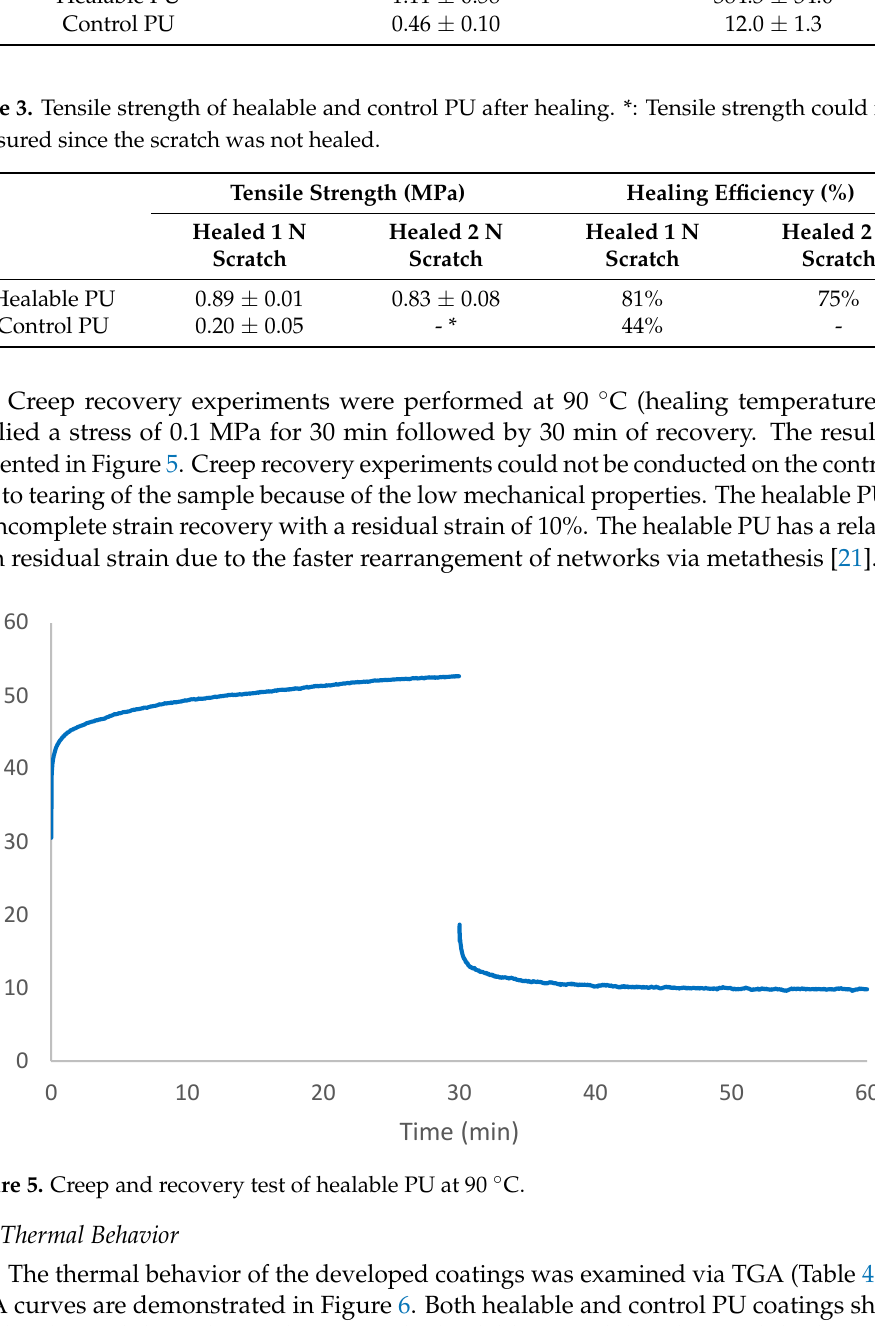
Table 4. Overview of T 5% and weight residue at 600 °C for the bio-based 2K PU coatings.